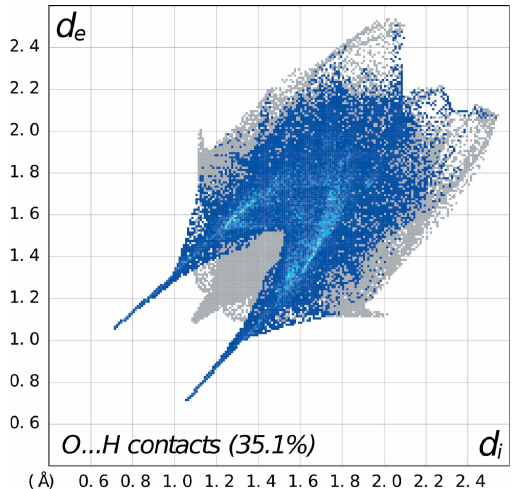
Figure 7 Fingerprint plot for 2 delineated into F (cid:2)(cid:2)(cid:2) H/H (cid:2)(cid:2)(cid:2) F contacts showing the